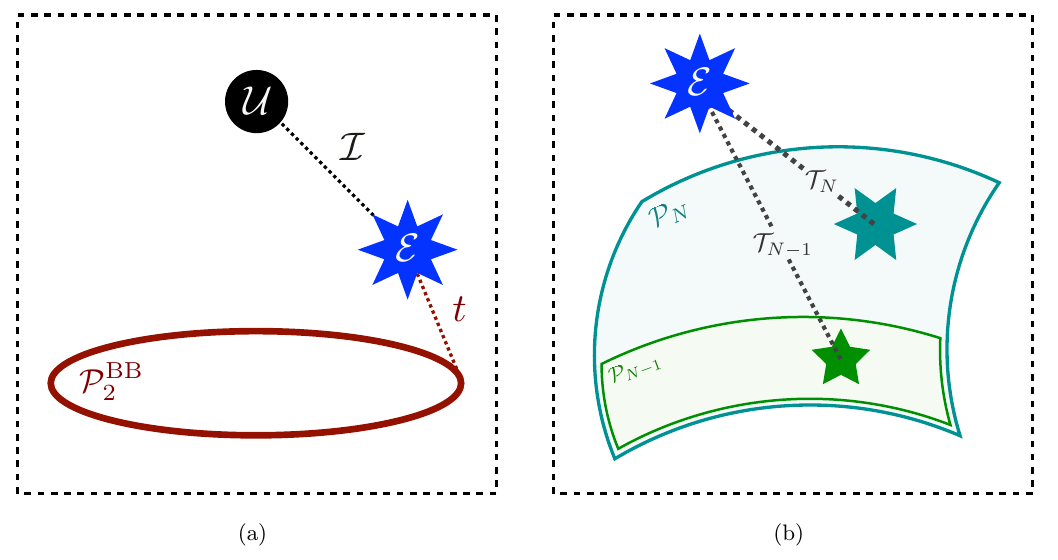
Figure 5 . An illustration of a variety of observables as distances between an event manifolds in the space of events, as summarized in table 4. (a) Thrust t is the smallest distance from the event to the manifold the distance to the uniform event the event to the N -particle manifolds